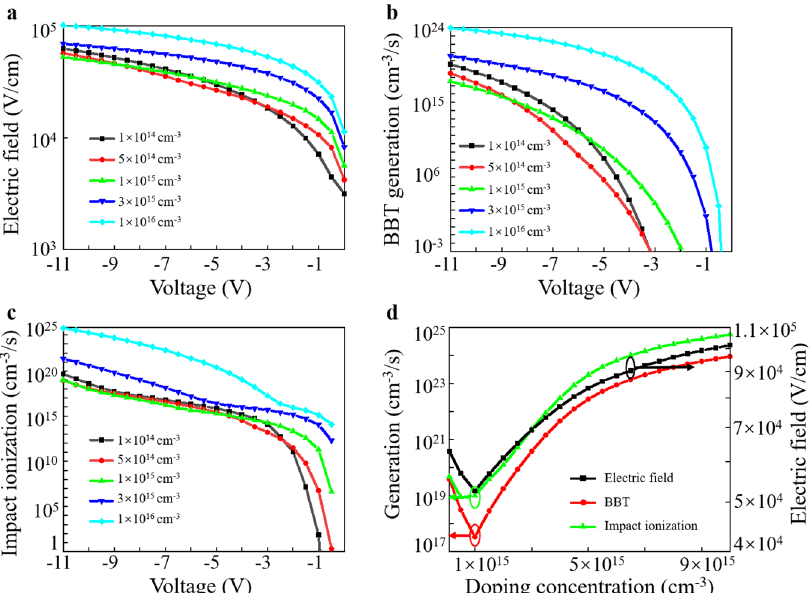
Fig. 3 Doping concentrations in fl uence the electric fi eld and BBT, impact ionization generations. a Electric fi eld, b BBT generation, and c impact ionization generation with various doping concentrations at different bias voltages. d Electric fi eld, BBT, and impact ionization generations as a function of doping concentration at − 11 V.